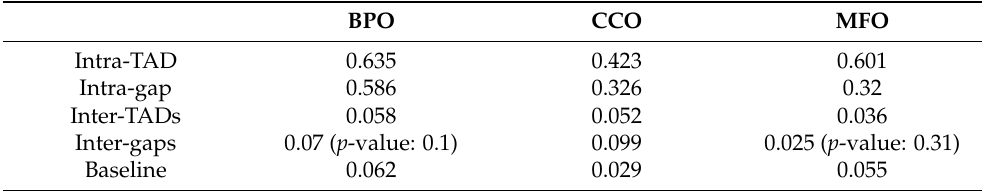
Table 1. The Pearson’s correlations between functional similarities and expression similarities (func ‐ tional threshold >0.2). Only two Pearson’s correlations have >0.05 p ‐ values ( p ‐ value listed in paren ‐ thesis). All other correlations have <0.05 p ‐ values.